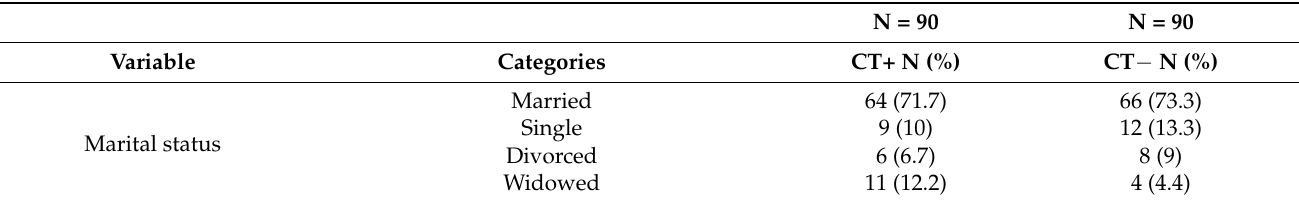
Table 1. Sociodemographic data and characteristics of the